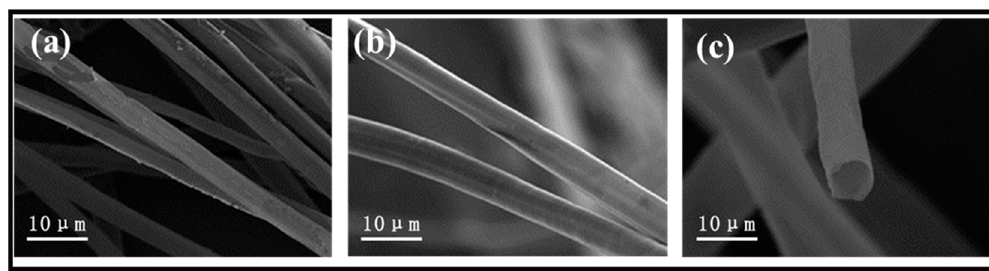
Figure 1. ( a ) SEM image of non-treated PC and ( b , c ) SEM images of treated PC.